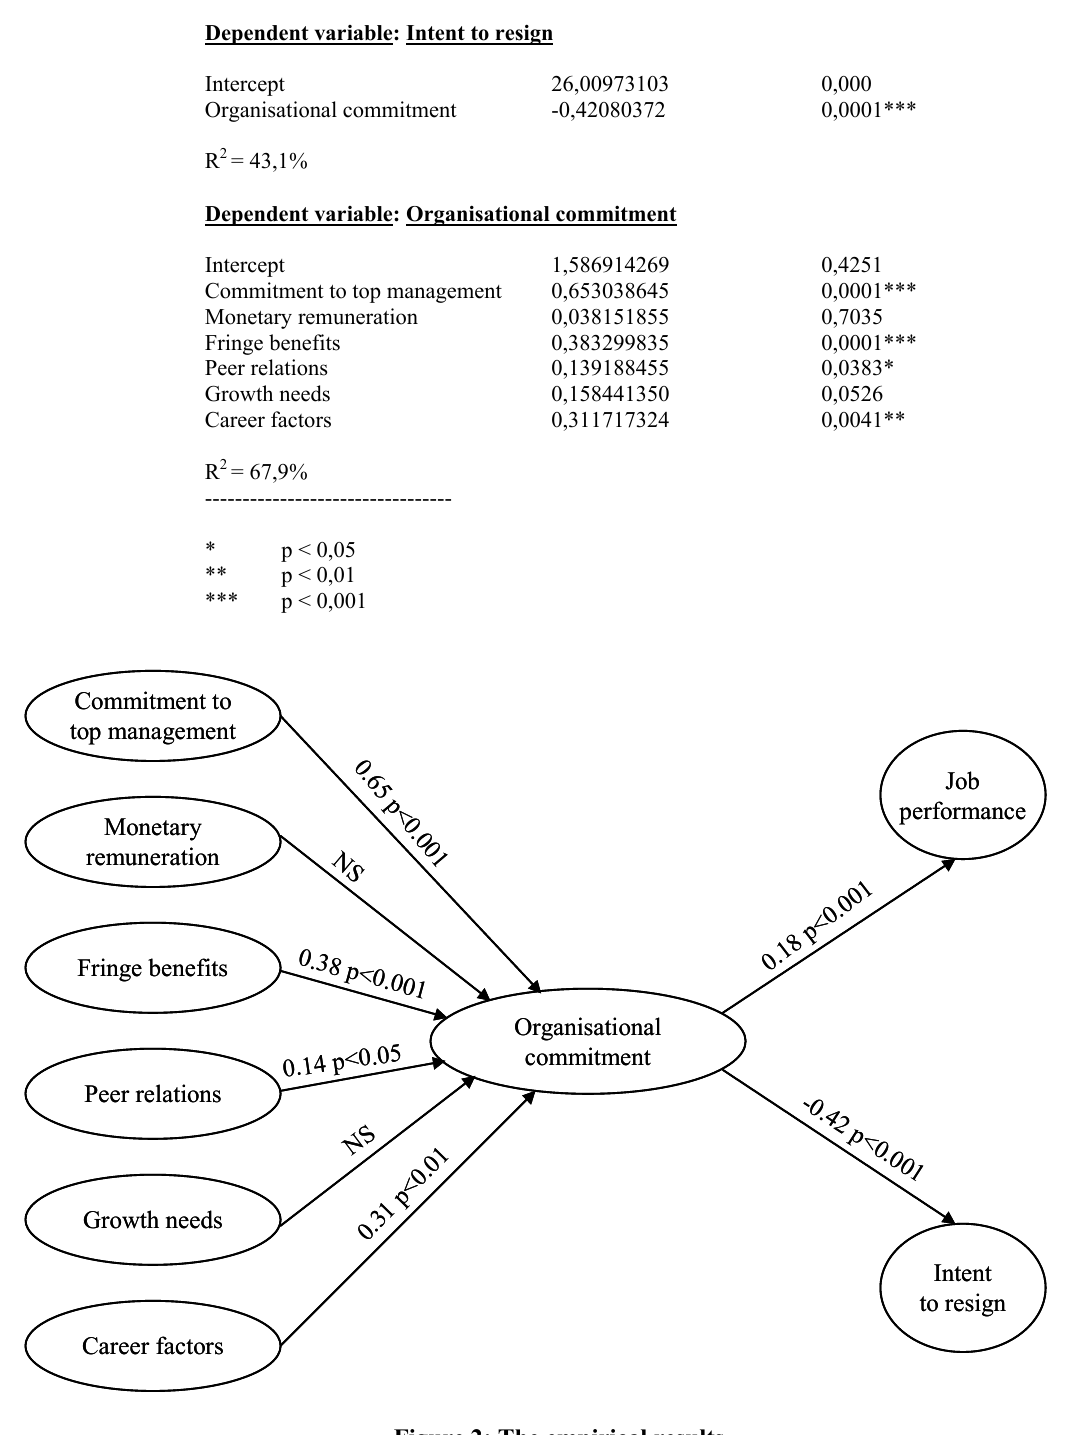
Figure 2: The empirical